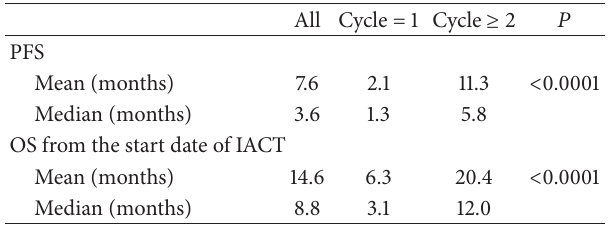
Table 2: Treatment response. Table 3: Survival